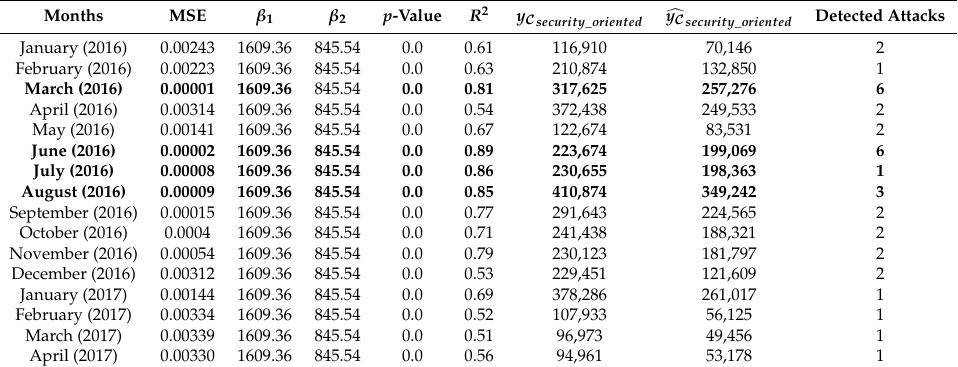
Table 6. Regularized regression measures report.